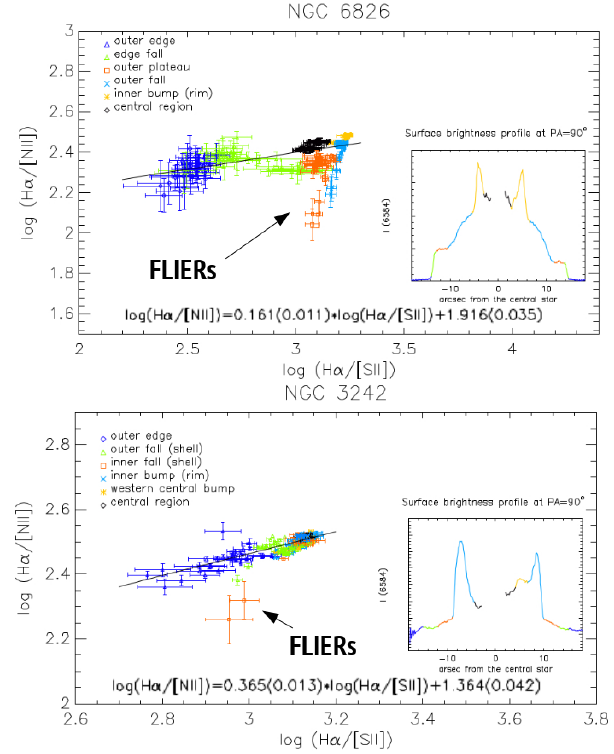
Figure 3. The E2DDs for of a nebula with very pronounced FLIERS and one with very weak